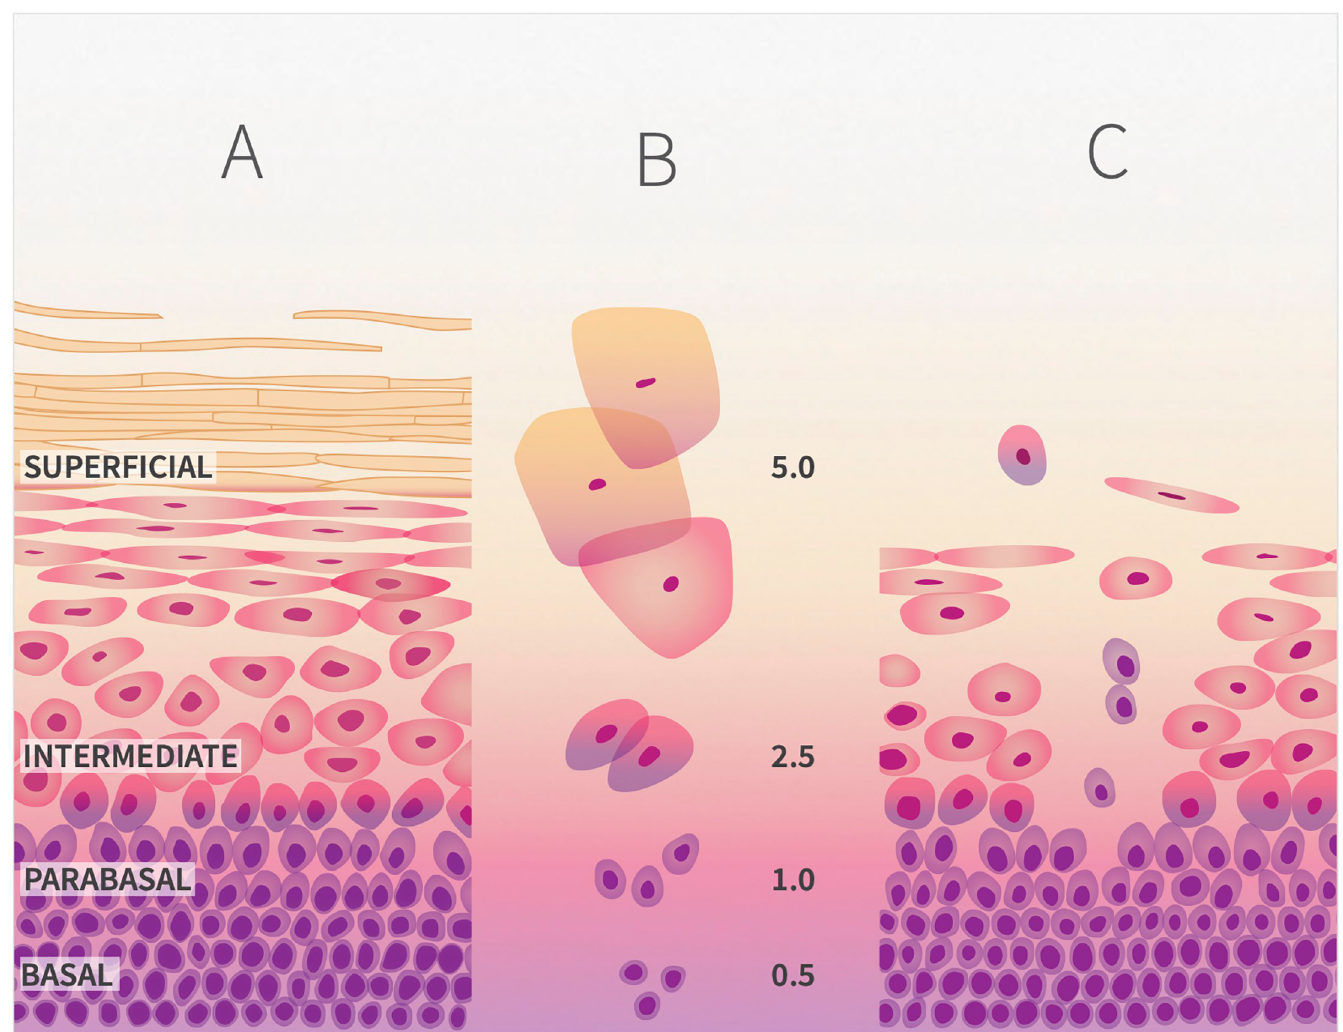
Fig 1. A. The vaginal epithelium undergoes morphological changes during maturation. As cells mature, they migrate from the basal layer, to the parabasal and intermediate layers to the superficial layer from which they are shed. B. Morphological changes of the vaginal epithelium during maturation include decrease in nuclear and increase in cytoplasmic sizes, which provides the basis of the Maturity Index value (values shown are representative of each layer). C. Shedding of immature cells indicates depletion of superficial cells, and loss of structural integrity of the vaginal epithelial